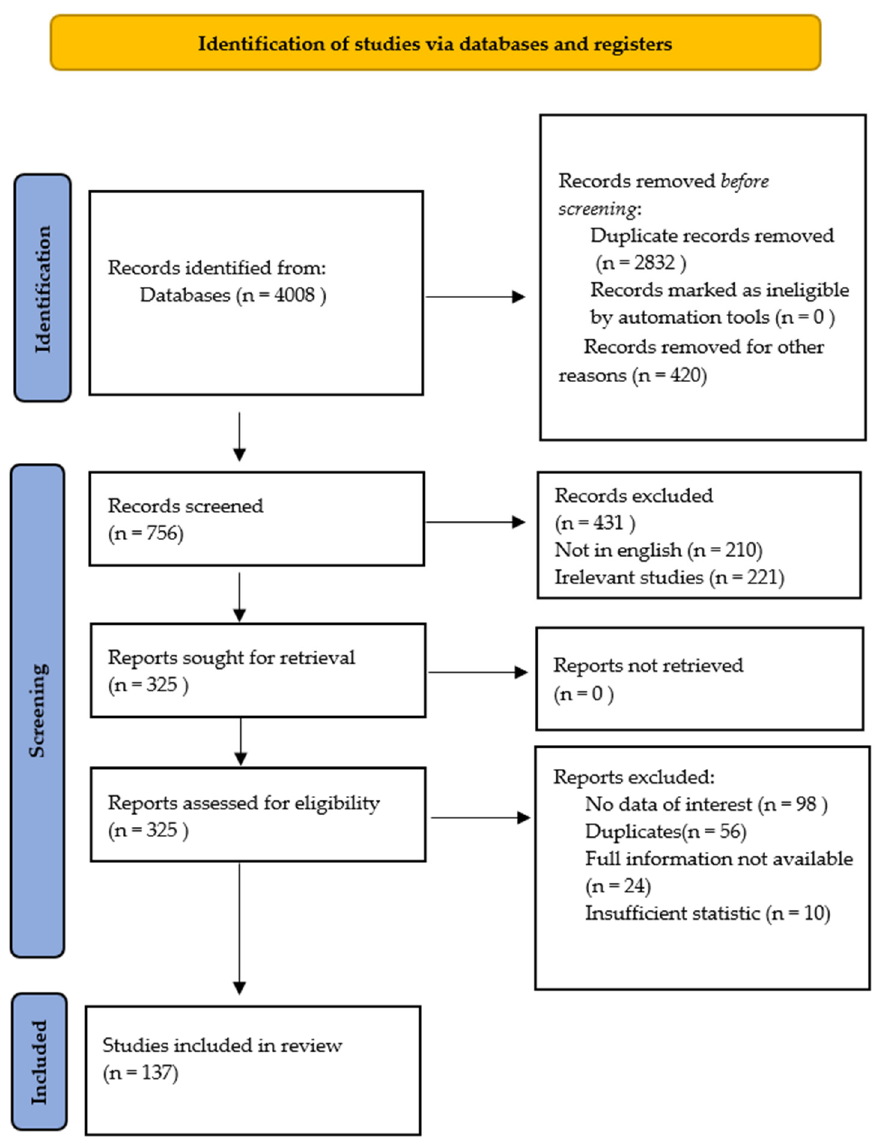
Figure 4. PRISMA 2020 flow diagram for new systematic reviews, which includes database and register searches only.